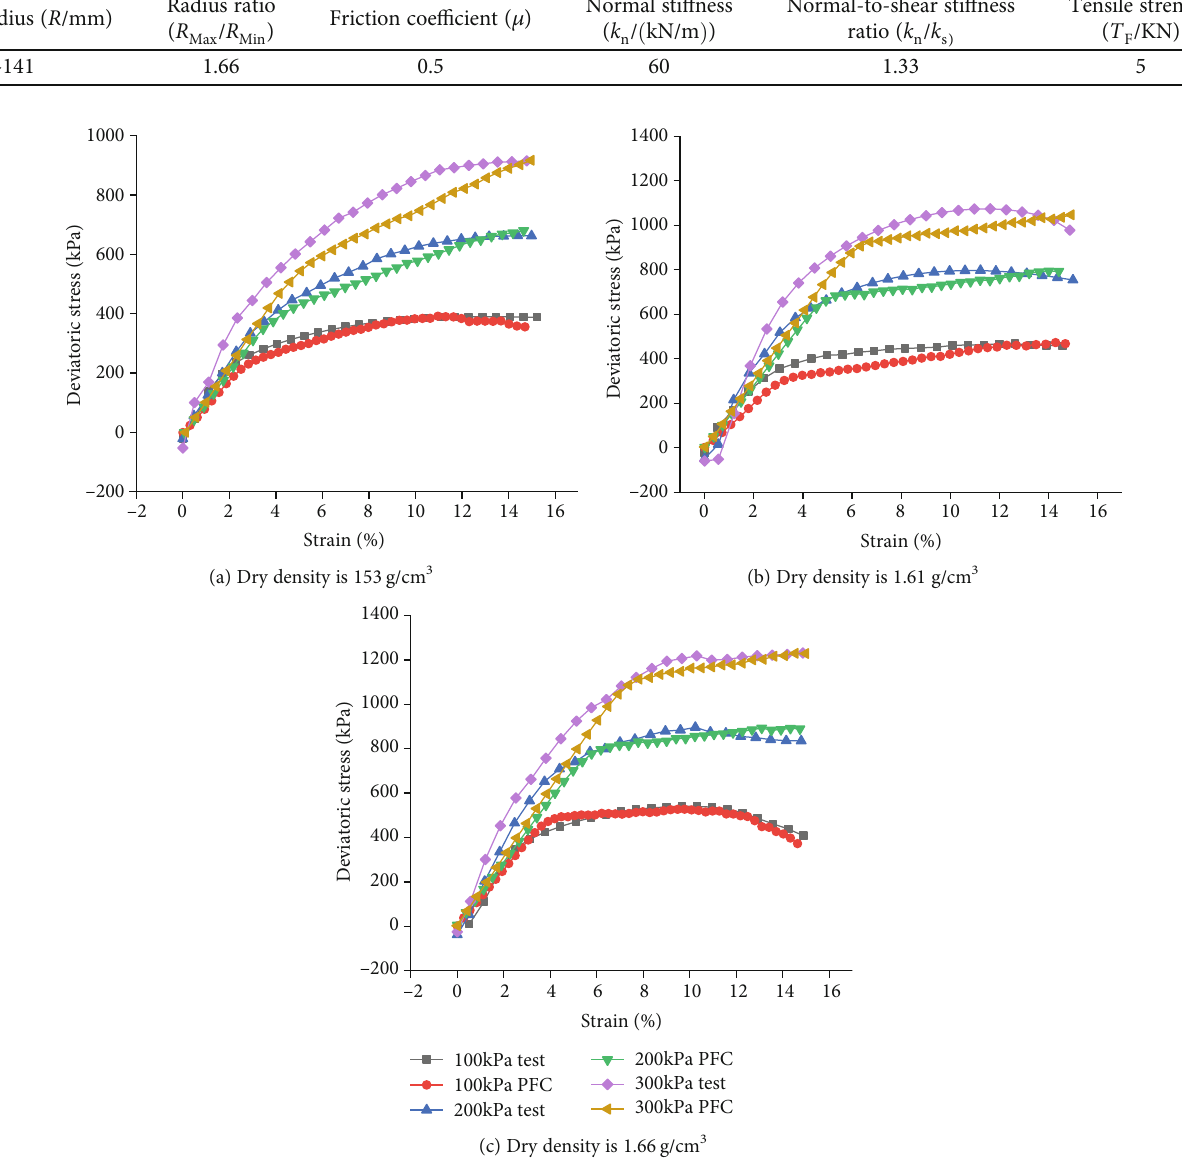
Figure 6: Stress-strain curves of laboratory tests and PFC